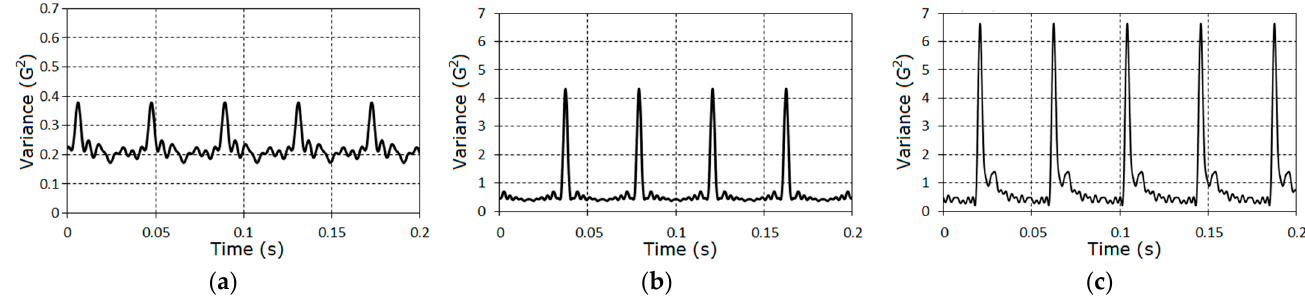
Figure 15. The estimators of the variance for the vibrations stochastic parts for the first ( a ), the second ( b ) and the third ( c ) stages.